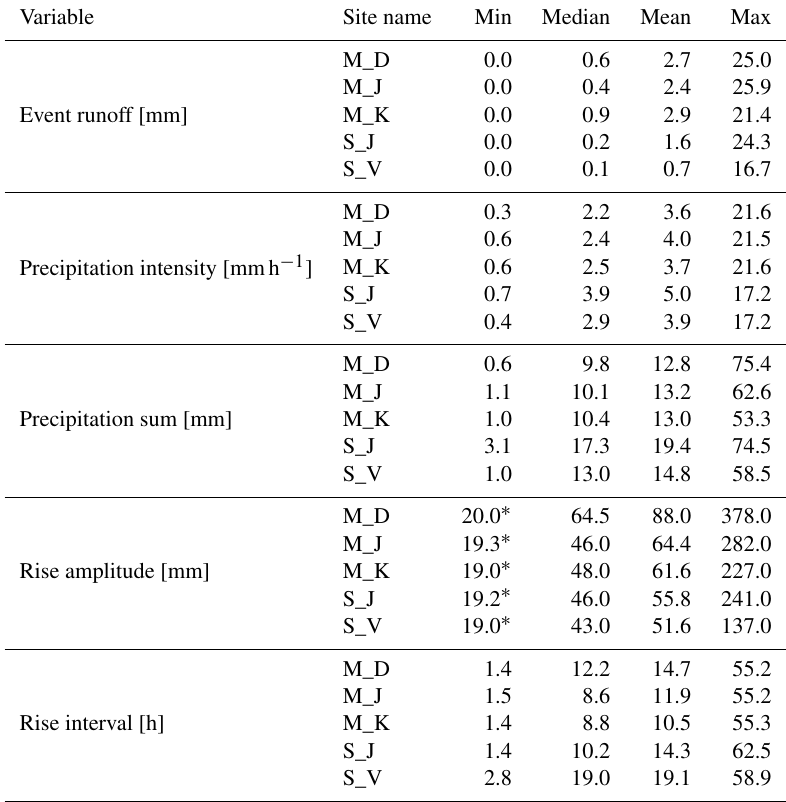
Table 2. Characteristics of the stream events summarised for each site. Different values for runoff and precipitation can occur as not all sites cover the same (number of) events. Also, different runoff and precipitation stations were used for marls and schist sites (see Fig. 1). An event runoff of 0.0mm can occur by subtracting baseflow from total